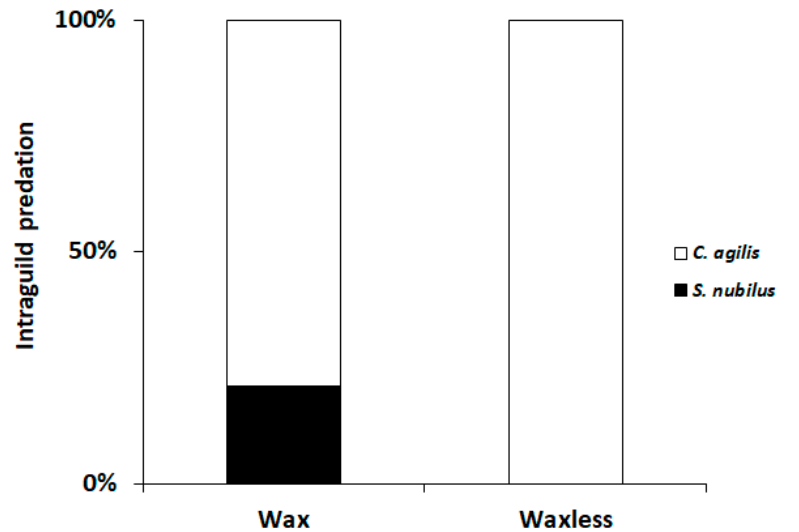
Figure 3. Rate of intraguild predation (RP) by the fourth instar of S. nubilus and second instar of C. agilis.